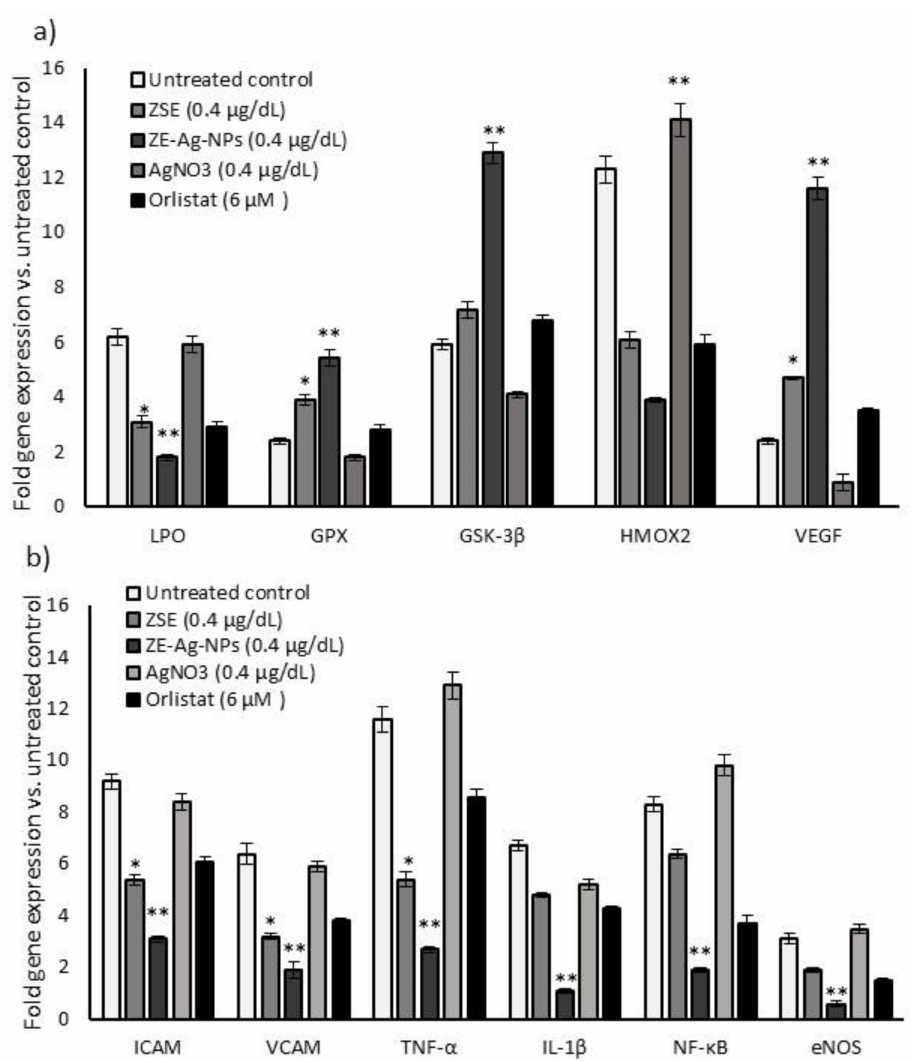
Figure 8. Effect of the vehicle control, ZSE, AgNO 3 , and ZS-Ag-NPs treated adipocytes condition media supplemented HUVECs on oxidative stress and antioxidant ( a ), vascular cell inflammation, and angiogenesis ( b ) related gene expression levels after 48 h. Each value is a mean ± SD ( n = 6). * significant at p ≤ 0.05 and ** highly significant at p ≤ 0.001, by comparison with the vehicle